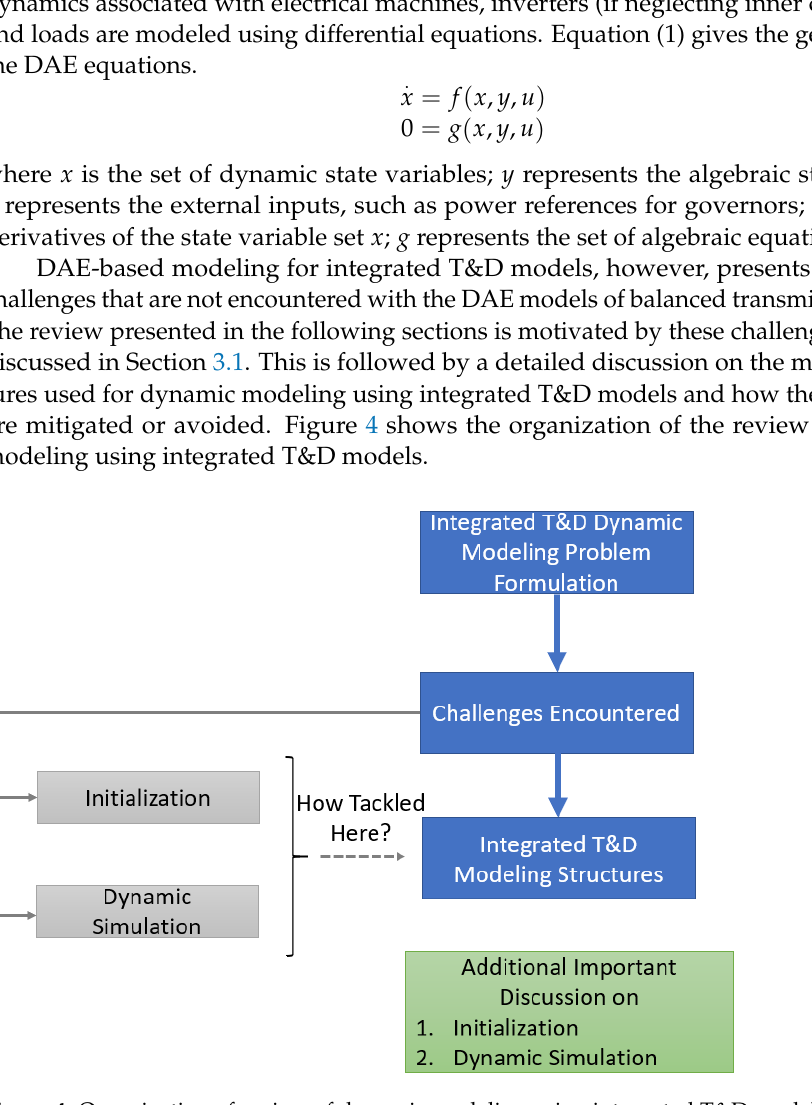
Figure 4. Organization of review of dynamic modeling using integrated T&D models.